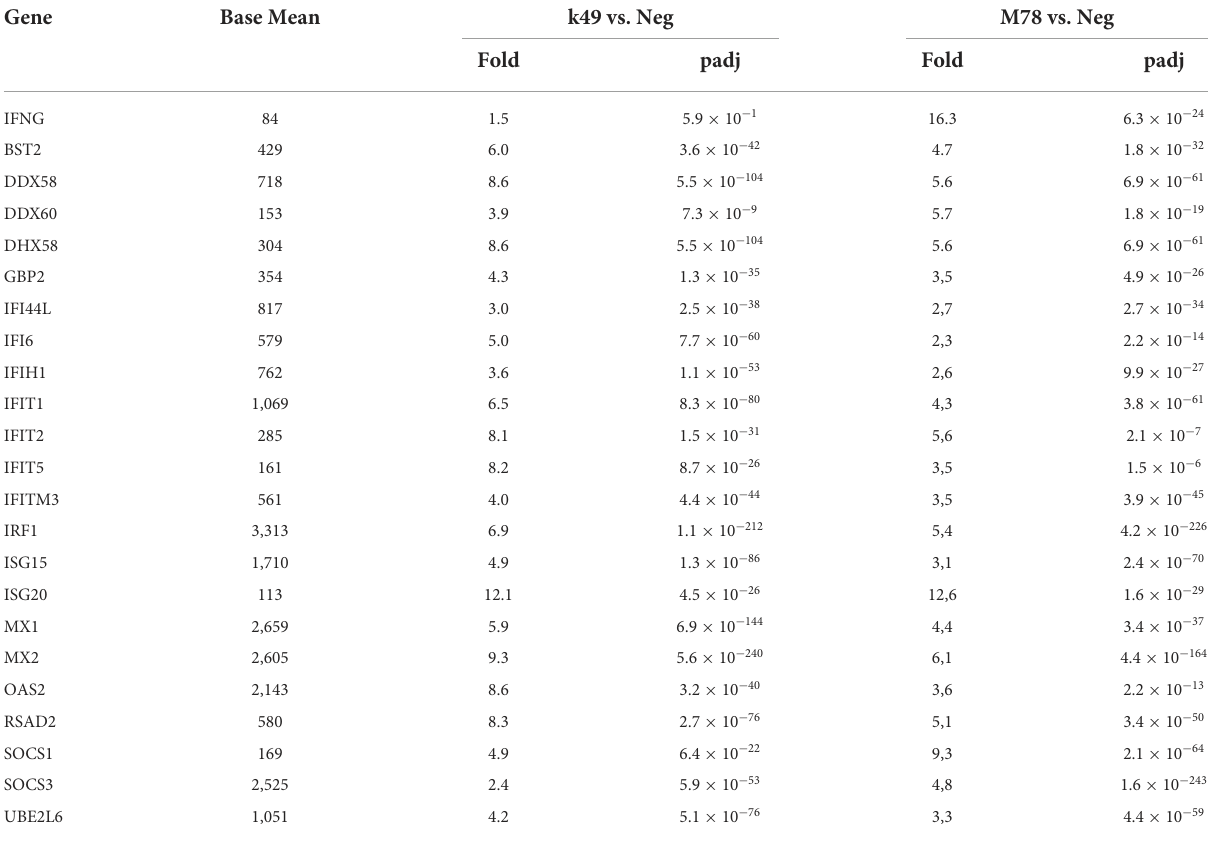
TABLE 4 Differential expression of interferon-stimulated genes in PBMCs infected with ASFV strains K49 or M78 (FDR ≤ 0.05). Gene Base Mean k49 vs. Neg M78 vs. Neg Fold padj Fold padj